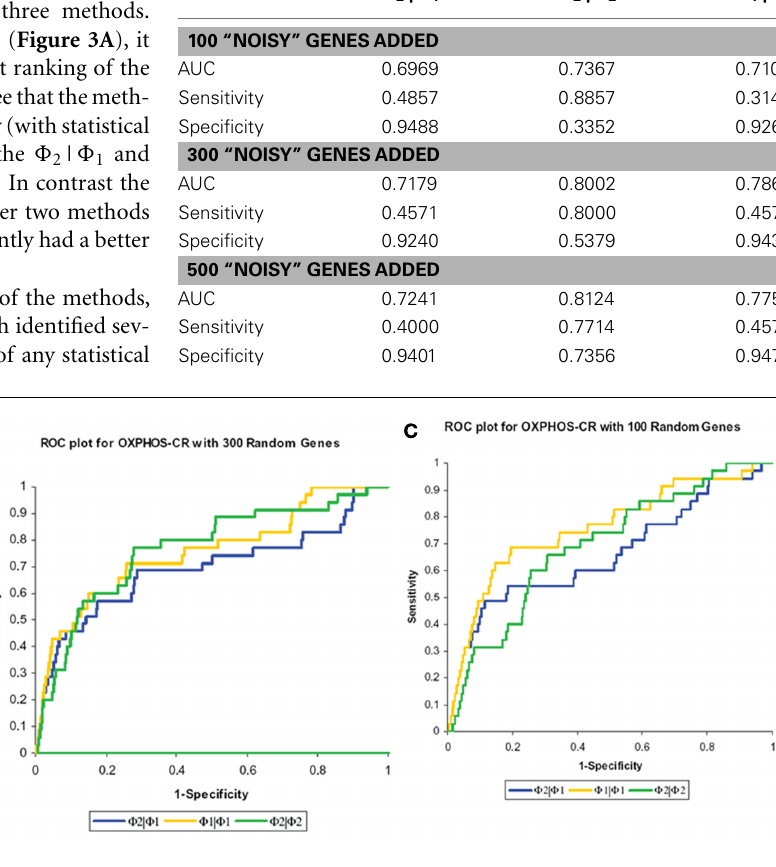
FIGURE 3 | Maintenance of rank. The methods were compared based on their ability to maintain the rank of the “golden standard” classifications. (A) ROC plot of the rankings of the classifications from the added 500 random